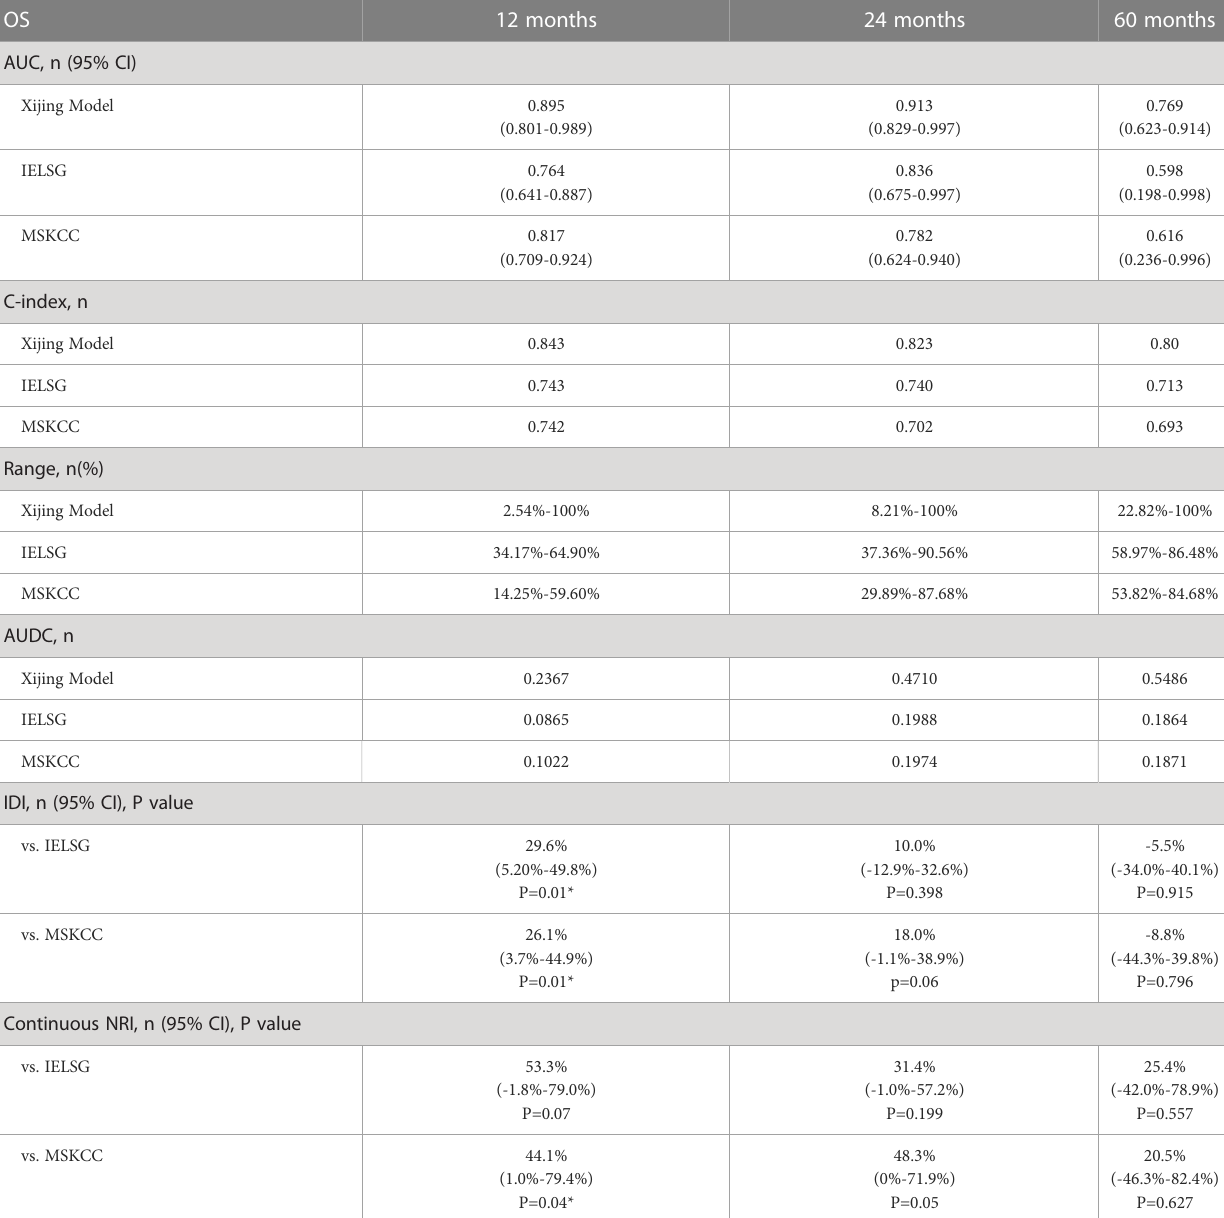
TABLE 6 Comprehensive evaluations of different models in the validation